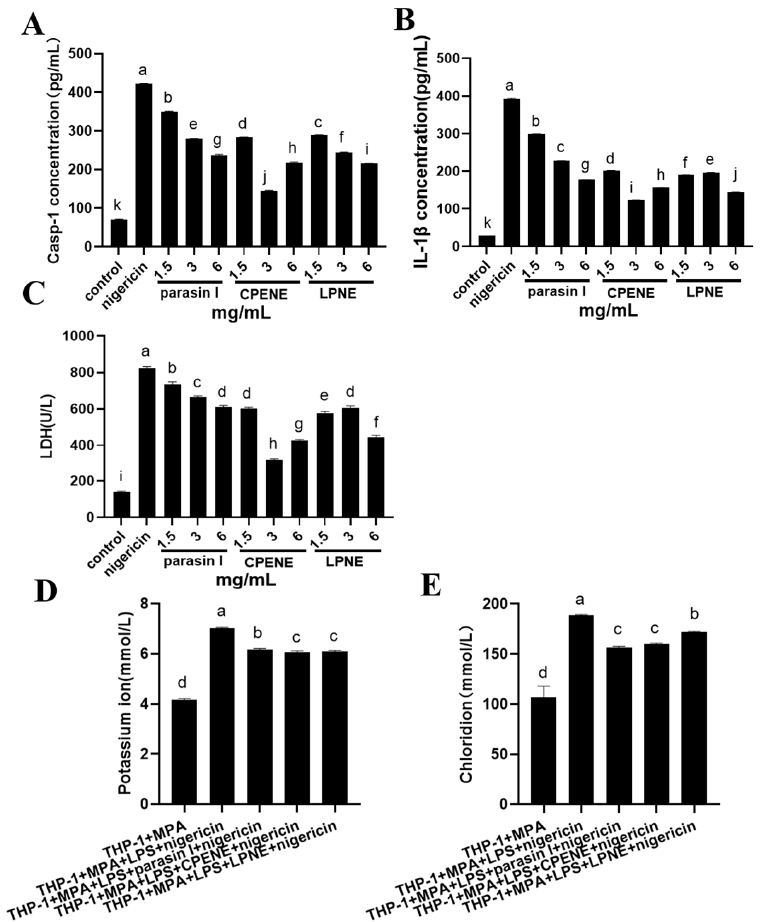
Figure 4. The Pickering emulsion enhances the inhibition effect of Parasin I on the activated NLRP3 inflammasome in THP-1. The casp-1 ( A ), IL-1 β ( B ), LDH ( C ) and potassium ( D ) and chloride ( E ) concentration in THP-1. Different letters (“a”–“k”) indicate significant differences ( p < 0.05). After the anti-inflammatory activity was evaluated, the mechanism of inflammasome inhibition in Pickering and parasin I needed to be explored. The activation of the inflam- masome needed the stimulus of a cascading signal. The release of potassium is generally